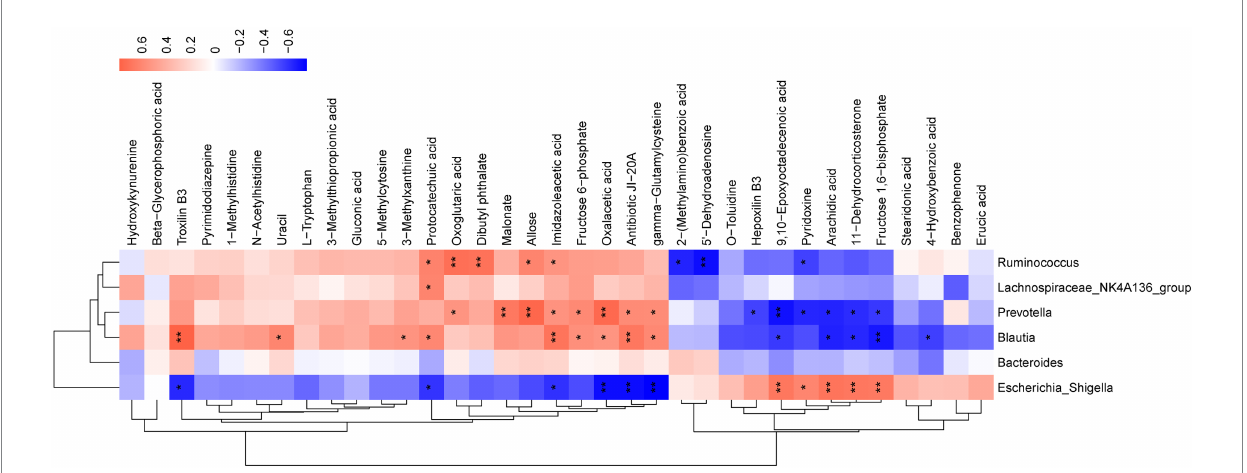
FIGURE 7 Correlation analysis of untargeted metabolomics and 16S rDNA sequencing. Red represents a positive correlation and blue represents a negative correlation. * p < 0.05, ** p < 0.01, *** p <